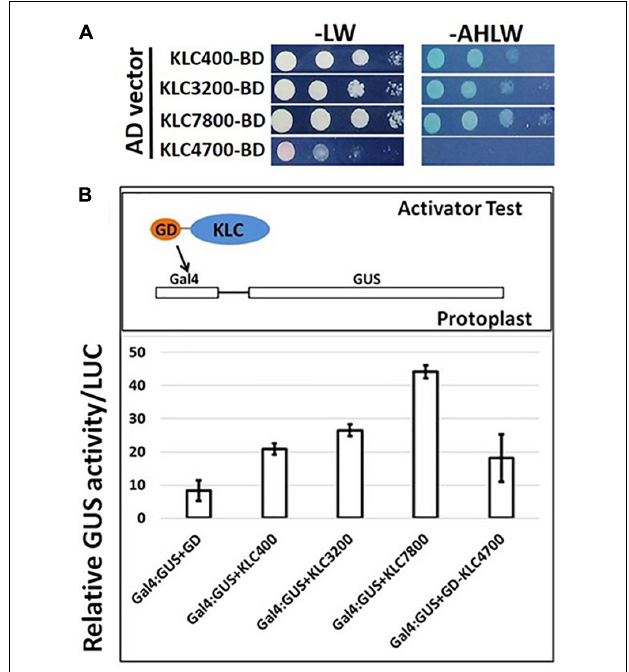
FIGURE 9 | Transactivation analysis of KLC proteins. (A) Yeast two-hybrid assays with KLCs in BD vector co-transfected with empty AD vectors and grown on minimal media lacking adenine, histidine, leucine and tryptophan. (B) Protoplasts co-transfected with GD-fused KLCs along with Gal4 :GUS reporter construct display GUS activity.